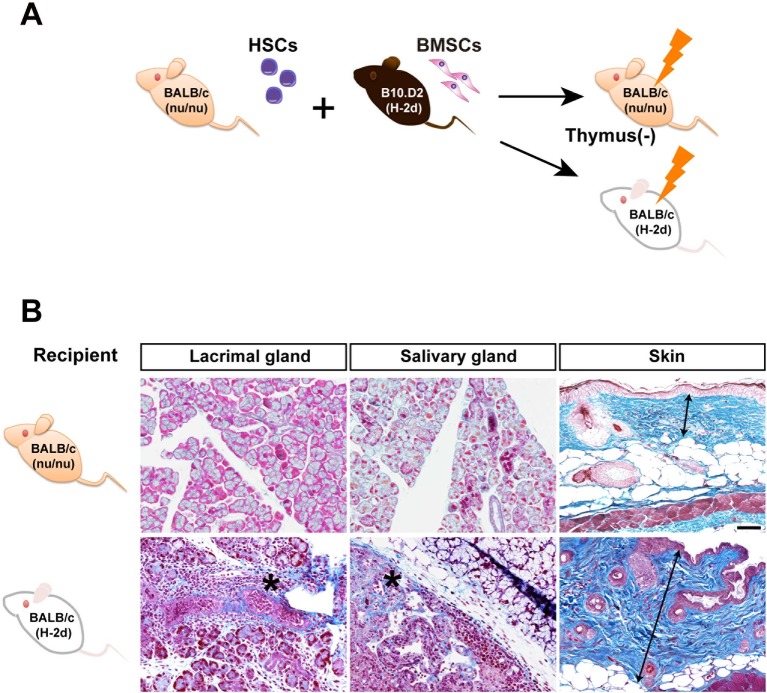
Mismatched PαS-BMSCs do not induce sclerodermatous fibrosis in recipient nude mice.(A) Transplantation scheme of B10D.2 (Mismatched) PαS-BMSCs and BALB/c-nu/nu (Syngeneic) SP-HSCs into nu/nu or wild type BALB/c. (B) Mallory staining of the lacrimal gland, salivary gland, and skin in BALB/c-nu/nu (top) and wild-type (bottom) recipient mice lacrimal gland and salivary gland at 3 weeks and skin at 8 weeks after transplantation. Data collected from two replicate experiments (n = 3 per group). Scale bar, 50 μm. *, areas of lymphocytic infiltration and excessive fibrosis in deep blue, double arrow; thickness of epidermis. BMSC, bone marrow stromal/stem cells; HSC, hematopoietic stem cellsDOI: